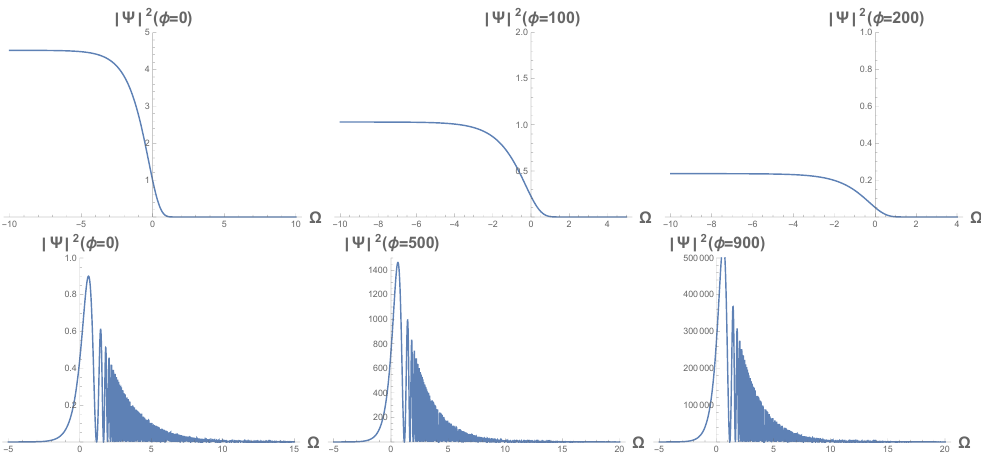
Figure 5. These graphs represent a break-off for the defined value in the scalar field φ , for the case in the factor ordering Q = 1, taking into account both solutions (50) given in Figure 3. The first line corresponds to the solution with the modified Bessel function, and the second line employs the ordinary Bessel function. This behavior appears in a similar way for different values in the factor ordering parameter, Q = − 1,0,1. We can see that the values in the amplitude of the probability density for big values in the scalar field, have very large growth, acting as a background in the classical